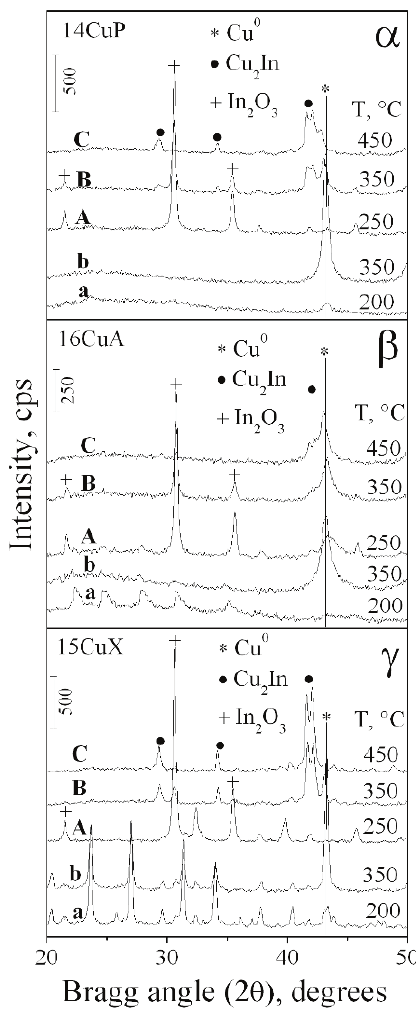
Figure 1. HT-XRD patterns of ( α ) 14CuP (a, b) and 15In (A, B, C) samples treated in H temperature for half an hour. Similar figures are shown for 16CuA ( β ) and 15CuX ( γ